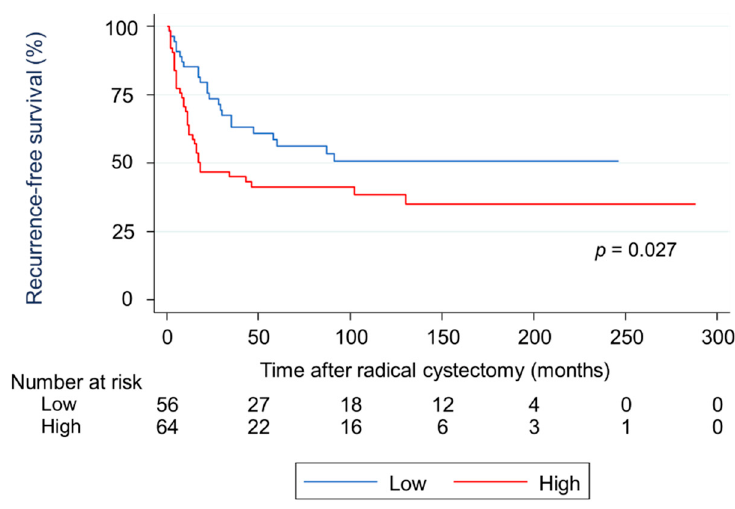
Figure 2. Survival analysis using Kaplan–Meier methods for recurrence-free survival in terms of two types of AHNAK2 expression. Patients in the high expression (HE) group showed a significantly worse recurrence-free survival than those in the low expression (LE) group.